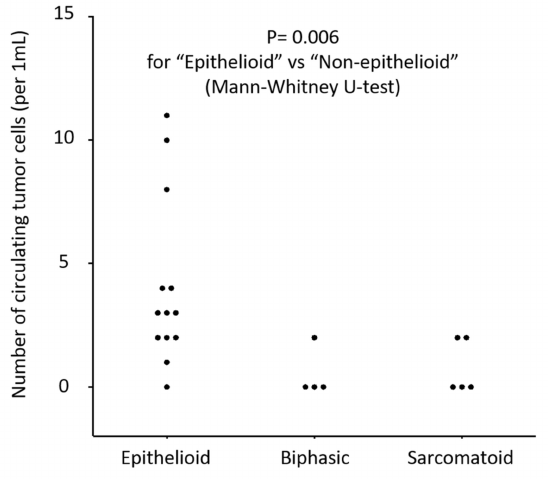
Figure 6. Distribution of the number of circulating tumor cells (CTC-count) detected with the CTC-chip in 1 mL of peripheral blood sampled from patients with malignant pleural mesothelioma (MPM) according to histologic subtype. The CTC-chip was coated with an anti-podoplanin antibody (clone NZ-1.2) to capture